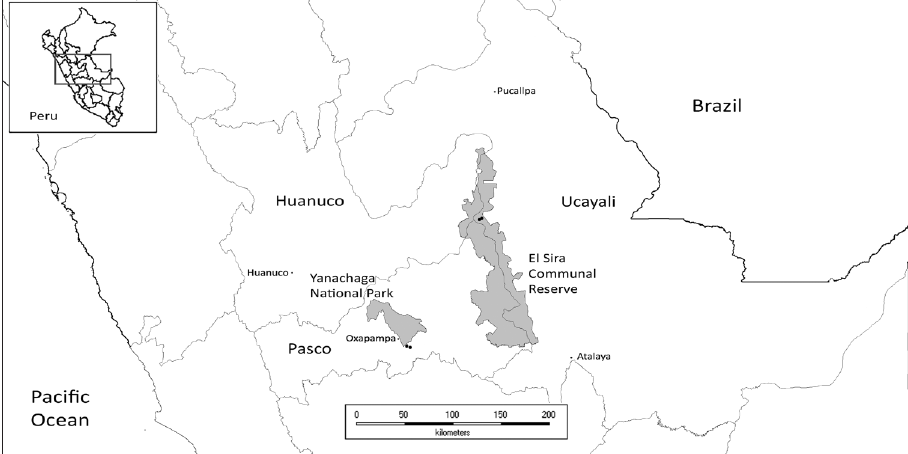
Figure 1. Location of known specimens of Brunfelsia cabiesesiana